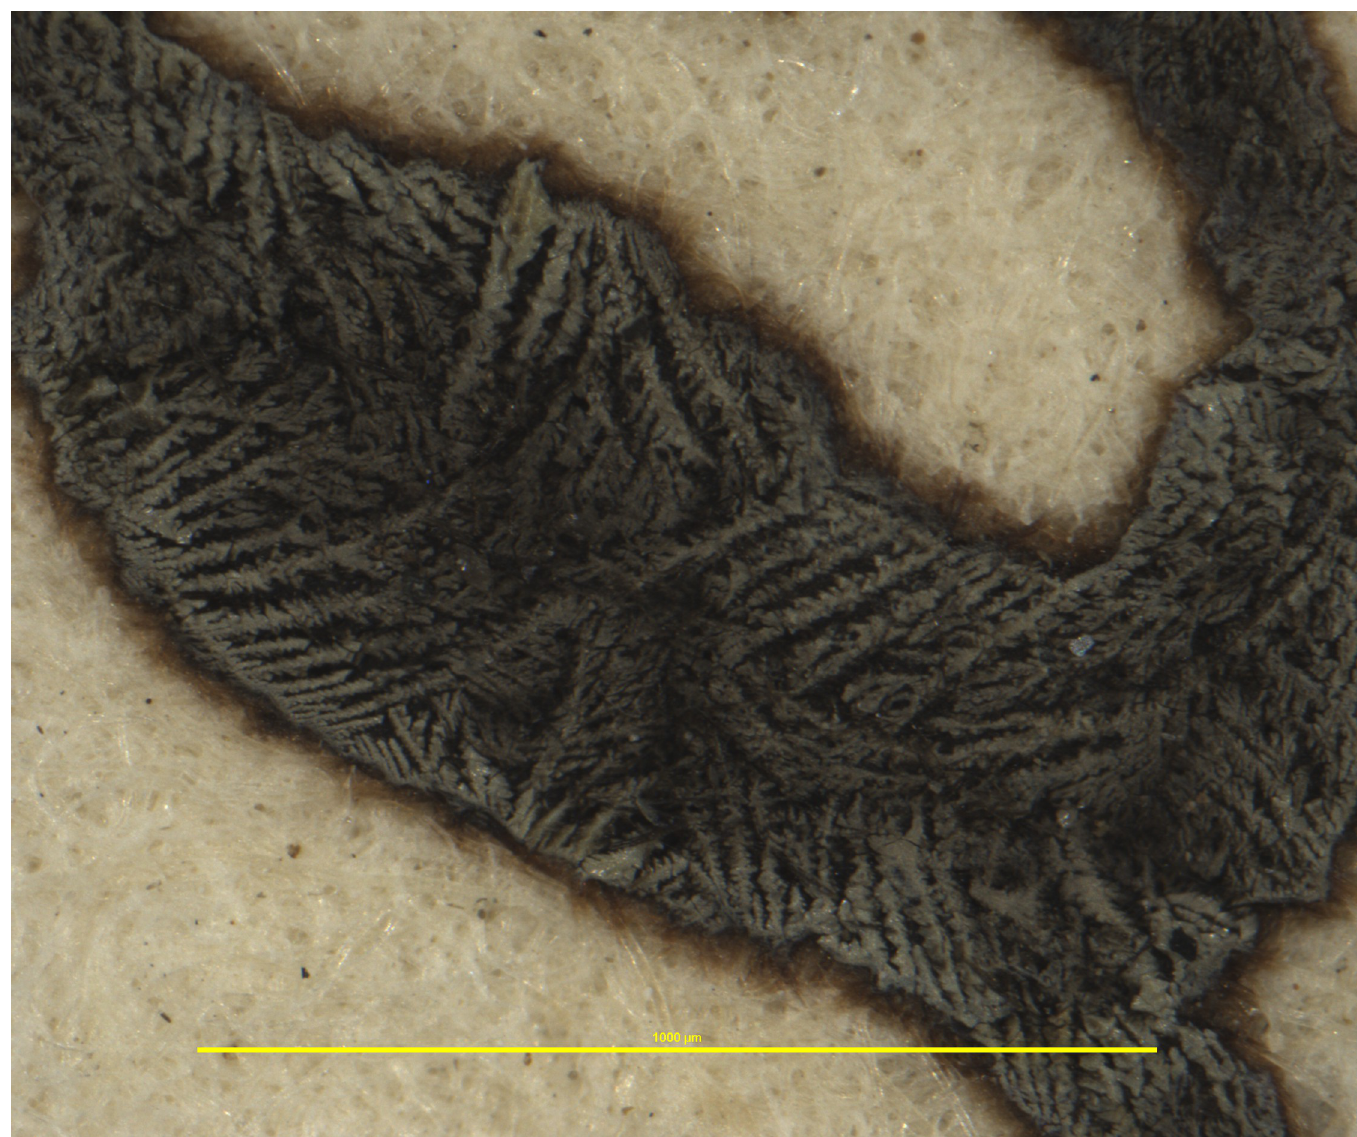
Fig 9. Feather-like sediments on ink. Example of different sediment structures found on inks in the Azzolino collection, here with a feather-like structure and a dull surface. This particular document from volume K 427 of the Azzolino